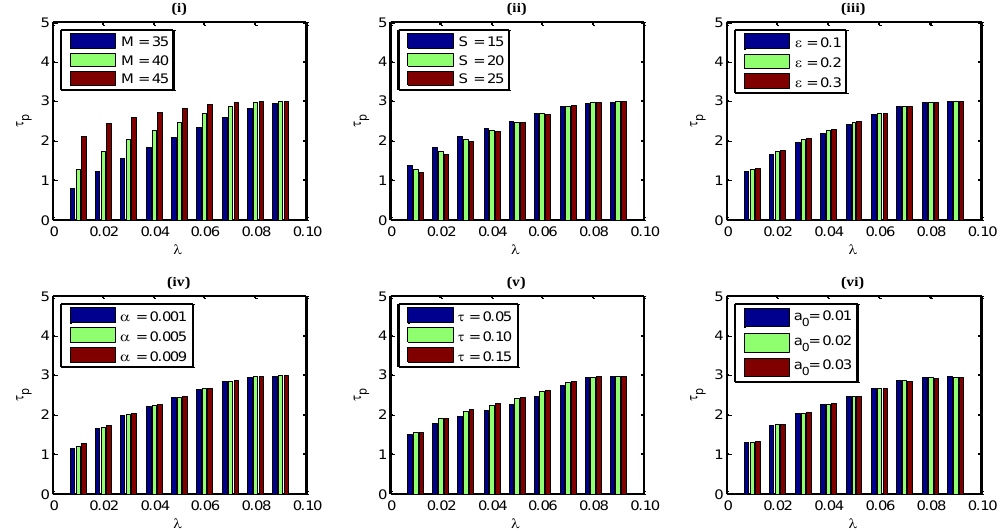
( )  wrt the failure rate of the operating machines ( )  p